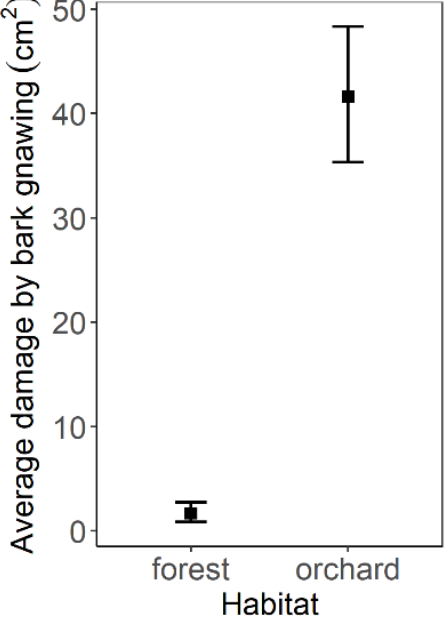
Figure 2. Average damage by gnawed bark area (cm 2 ) in studied forests and orchard in 2019.